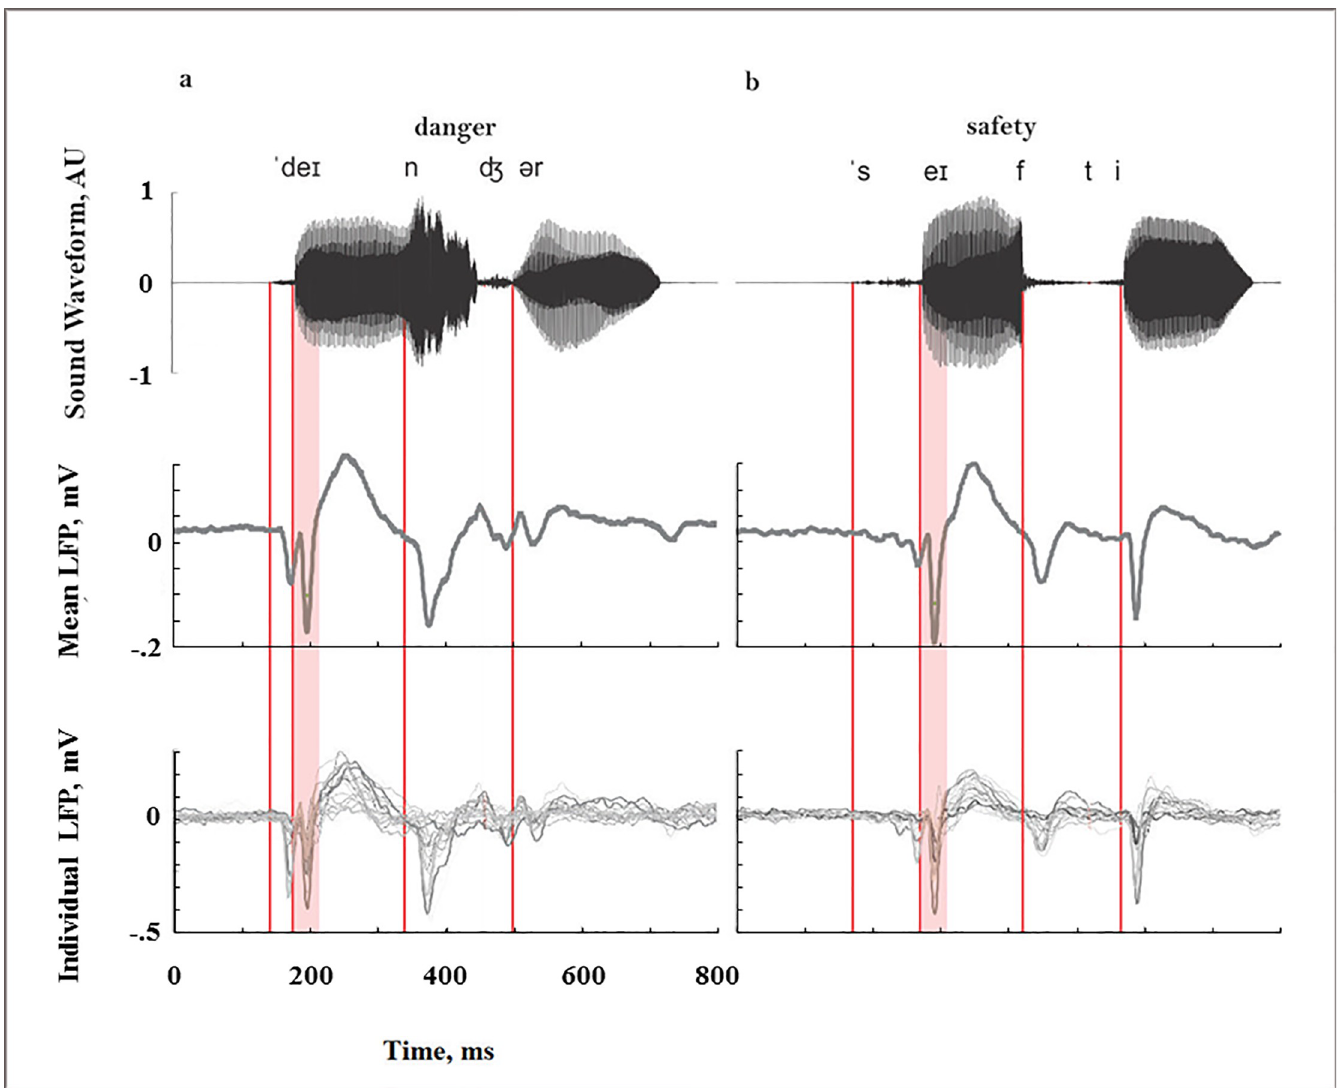
Fig 3. Responses to word-like stimuli. The waveform of the word-like stimuli (top), mean LFP responses over all electrodes and all animals (middle), and the average responses for all electrodes within animal, plotted for all animals (bottom). (a) For the word ’danger’. (b) For the word ’safety’. The waveforms are normalized (to a maximum of 1), since they were presented to different animals at a range of sound levels. The red lines mark the four major acoustic events that occur in these stimuli: the onset of the initial consonants, the onset of the first vowels, the onset of the second consonant, and the onset of the second vowel. The light red stripe marks the time period containing the responses evoked by the onset of the first vowel, used to quantify the responses to the vowels and the resulting SSA in Figs 4–6. Thus, time 0 in Fig 5 corresponds to the 2 nd red line displayed here.